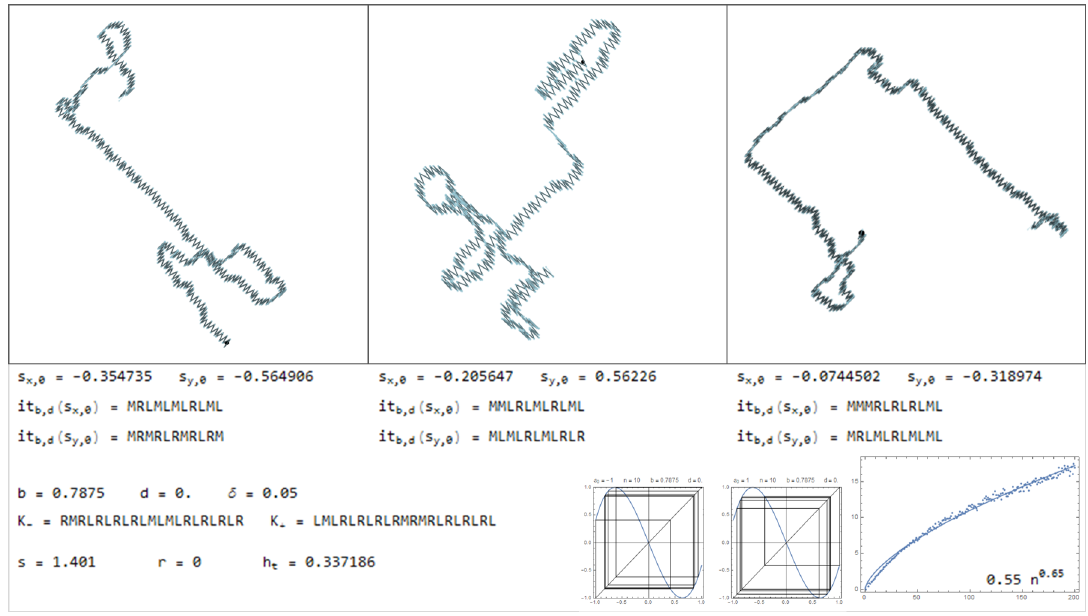
Figure 16. Trajectories produced with b = 0.7875 and d = 0.